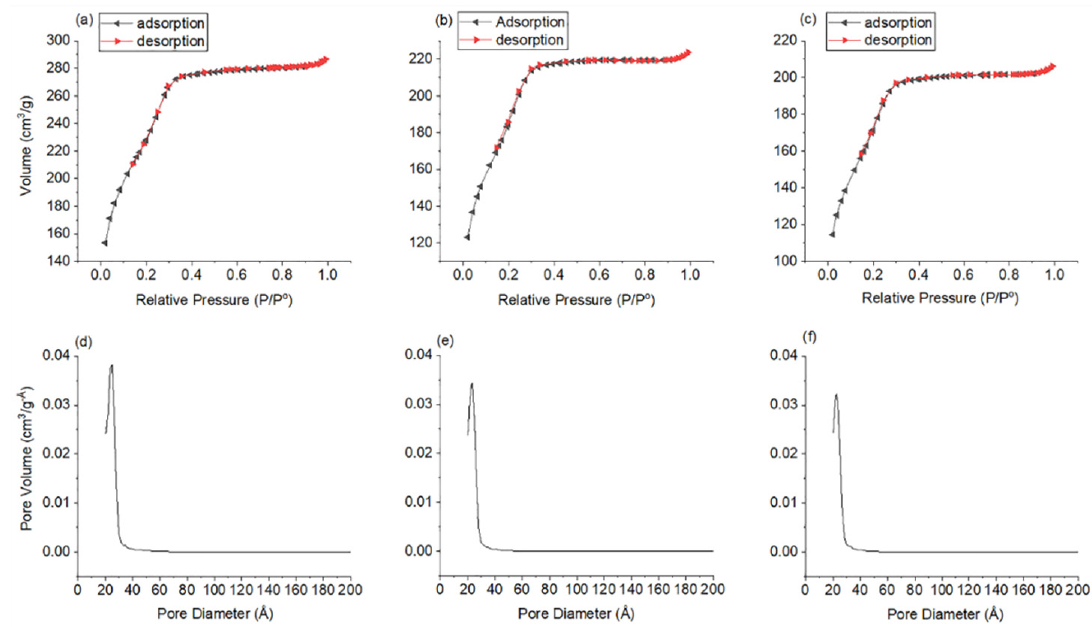
Figure 4. N 2 sorption analysis for ( a , d ) SBA-11, ( b , e ) control SBA-11 and ( c , f ) ZnO-SBA-11.